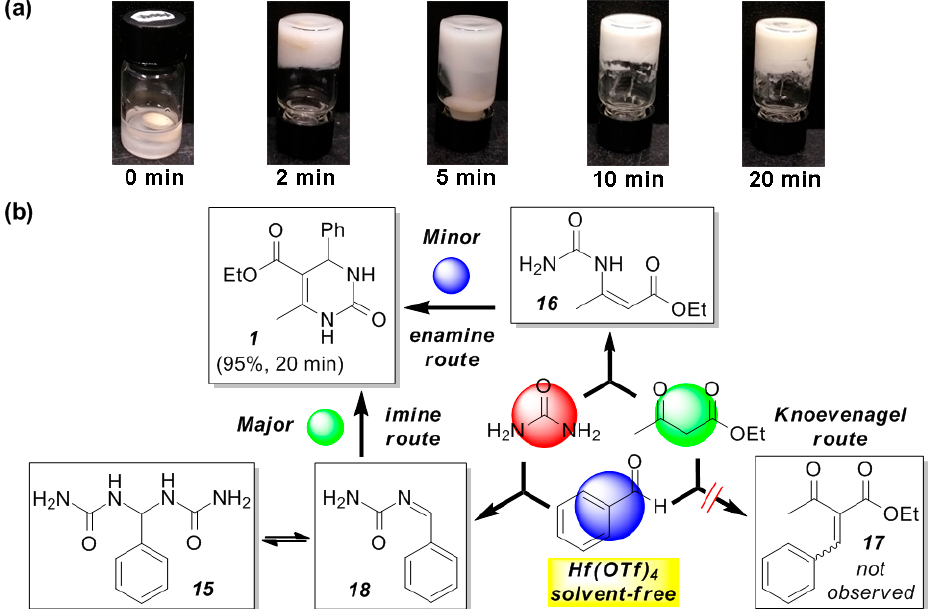
Figure 1. The photos ( a ) and proposed mechanism ( b ) for the Hf(OTf) 4 -catalyzed Biginelli reaction under solvent-free conditions.